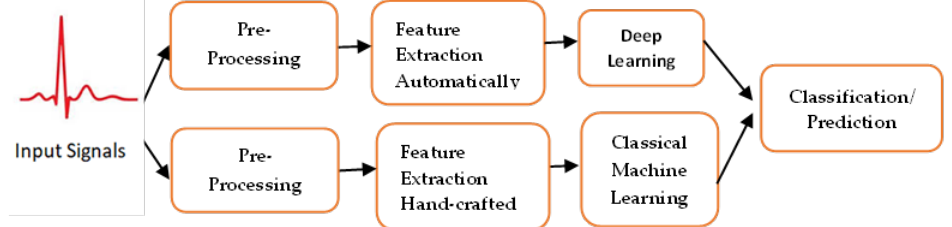
Figure 1. Deep learning-based methods that could extract features automatically, while classical machine learning needs human experts to extract features from the raw data, identify cardiac structural or functional abnormalities or make proactive predictions.